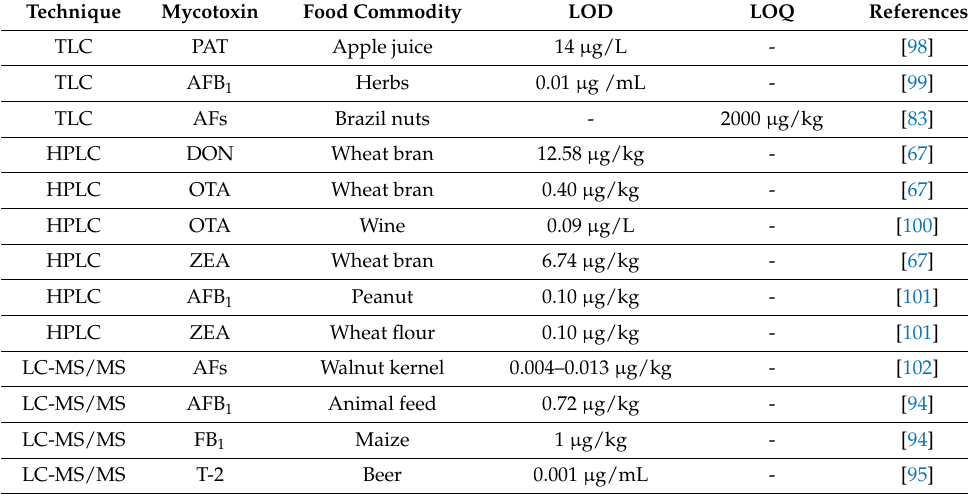
Table 2. Chromatography techniques used in mycotoxin